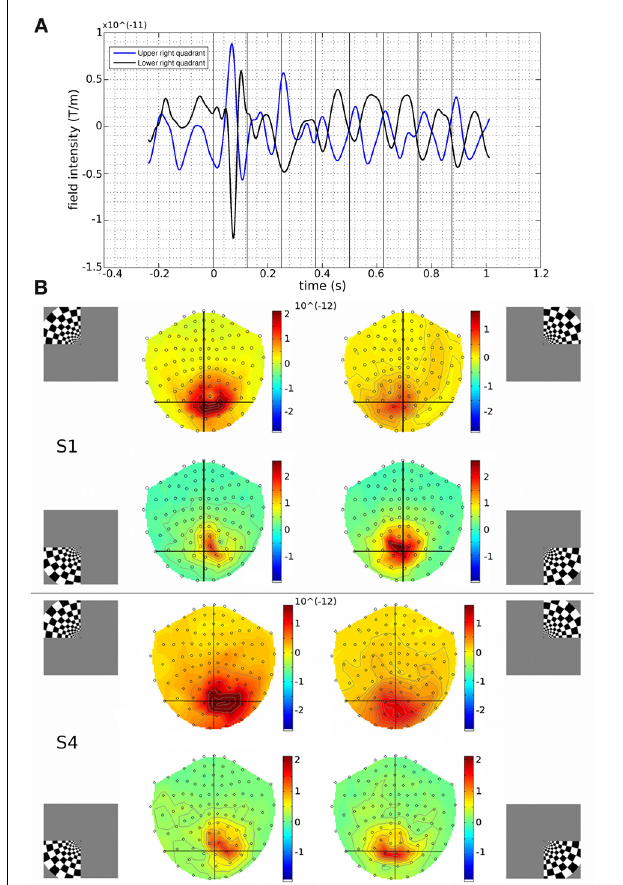
FIGURE 1 | (A) Measured responses to upper and lower right quadrant stimuli, from a MEG channel located over the occipital cortex (gradiometer channel 1922), for Subject 1. Traces were time-locked to the onset of the visual stimulus (time = 0) and averaged. Changes to the stimulus contrast occurred every 125ms following the onset of the visual stimulus (vertical black lines). Deflections of evoked responses to the upper and lower quadrants show opposite polarities, as might be expected from oppositely oriented current sources in the lower and upper calcarine banks respectively (Wandell et al., 2005). Source reconstructions were performed either on the visually evoked response (first response peak (FRP): centred at 83ms) or upon the ongoing stimulus-induced oscillations at 8Hz (200–1000ms). (B) Gradiometer topographic maps (T/m) of averaged evoked responses at 83ms post-stimulus for Subject 1 (S1) and Subject 4 (S4). Insets indicate stimulus locations. Black vertical and horizontal lines are presented to aid visualization. Peak responses tended to be over the hemisphere contralateral to the visual stimulus. Upper visual field stimuli evoked activation further back over the occipital pole than lower field